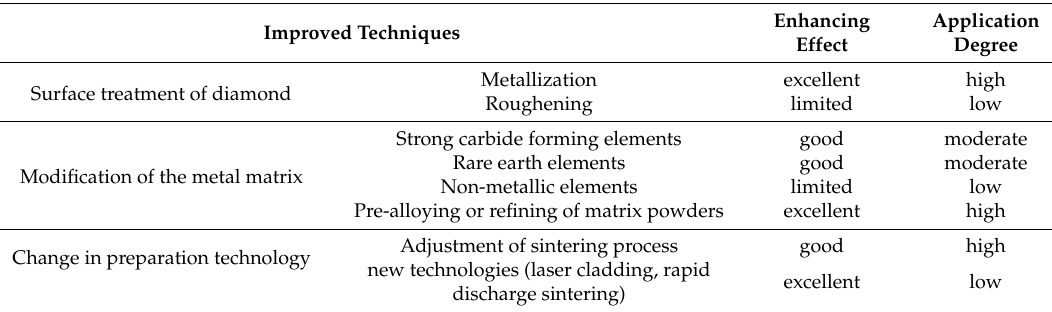
Table 2. Enhancing effect and application degree of different improved